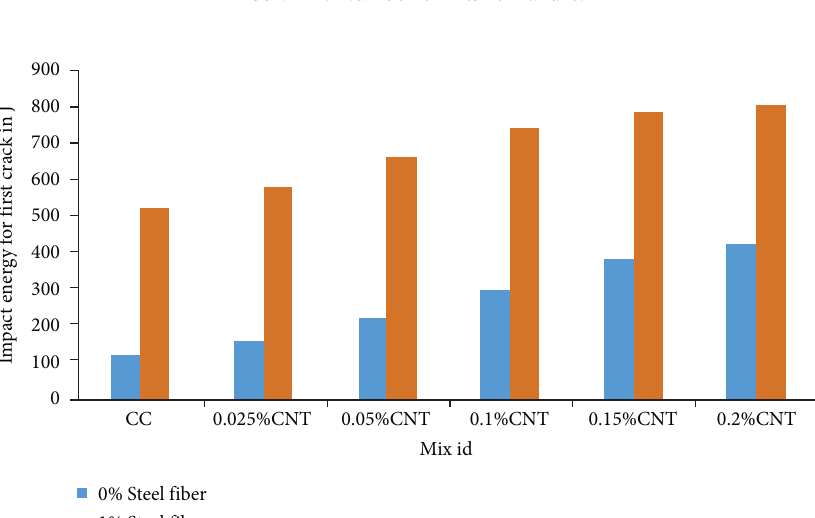
Figure 11: Number of hits for failure.